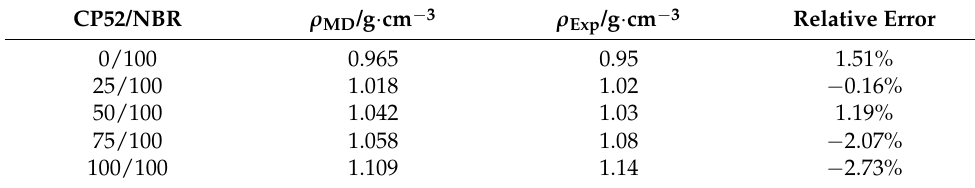
Table 2. Densities by simulations and experiments.